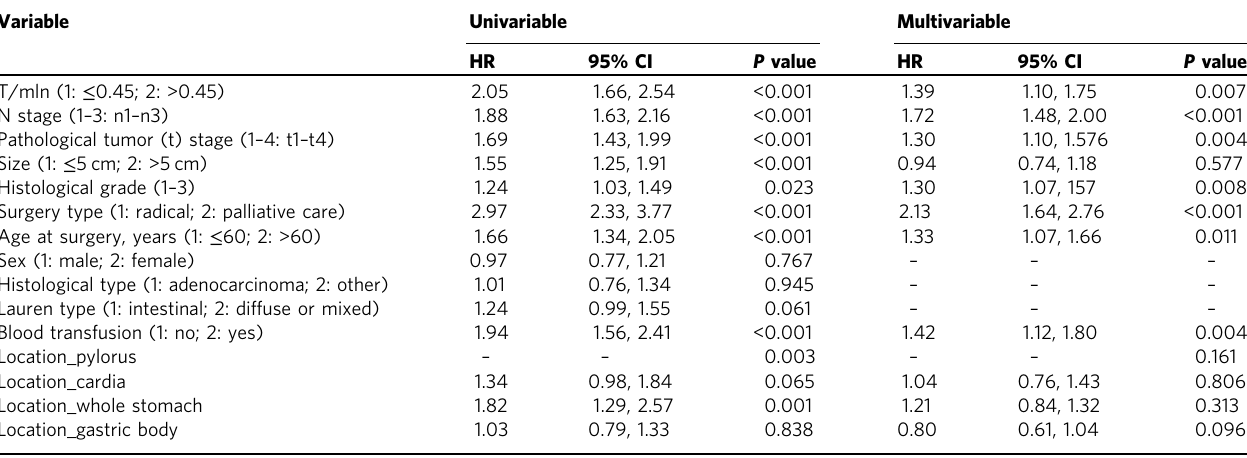
blood transfusion, location. and sex, and T/MLN had an HR of 1.39 and a 95% CI of 1.10 – 1.75 ( P = 0.007) (Table 1). In a strati fi ed analysis of cancer-speci fi c survival, the HR between gastric cancer patients with higher T/MLN and lower T/ MLN was similar in a subgroup of each patient characteristic (Fig. 5). In a Cox regression model of N-stage grouping, cancer- speci fi c survival of gastric cancer patients with higher T/MLN was shorter than that of gastric cancer patients with lower T/MLN (N1 stage: HR = 2.23, 95% CI 1.29 – 3.85, P < 0.001; N2 stage: